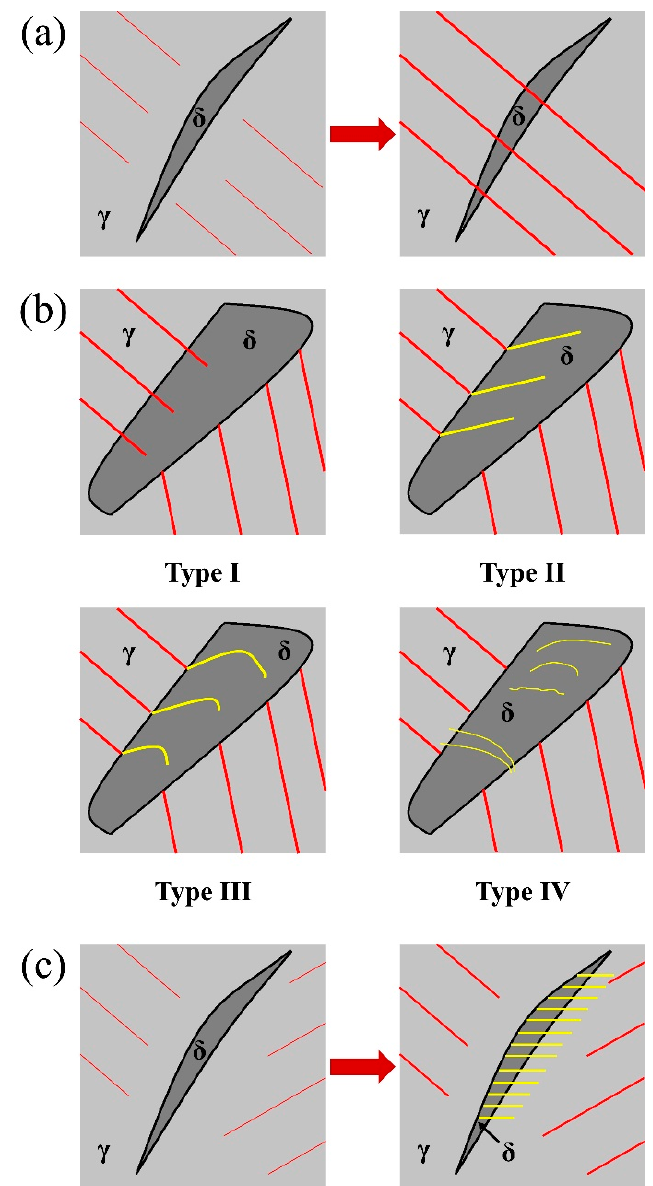
Figure 8. The slip deformation mechanisms of the Z3CN20.09M. ( a ) Narrow ferrite grains; ( b )